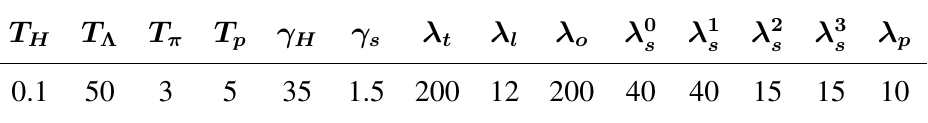
Table 2. Parameter settings for all